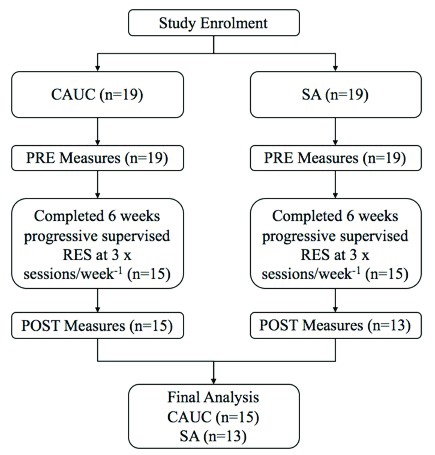
Flow of participants through the study protocol.